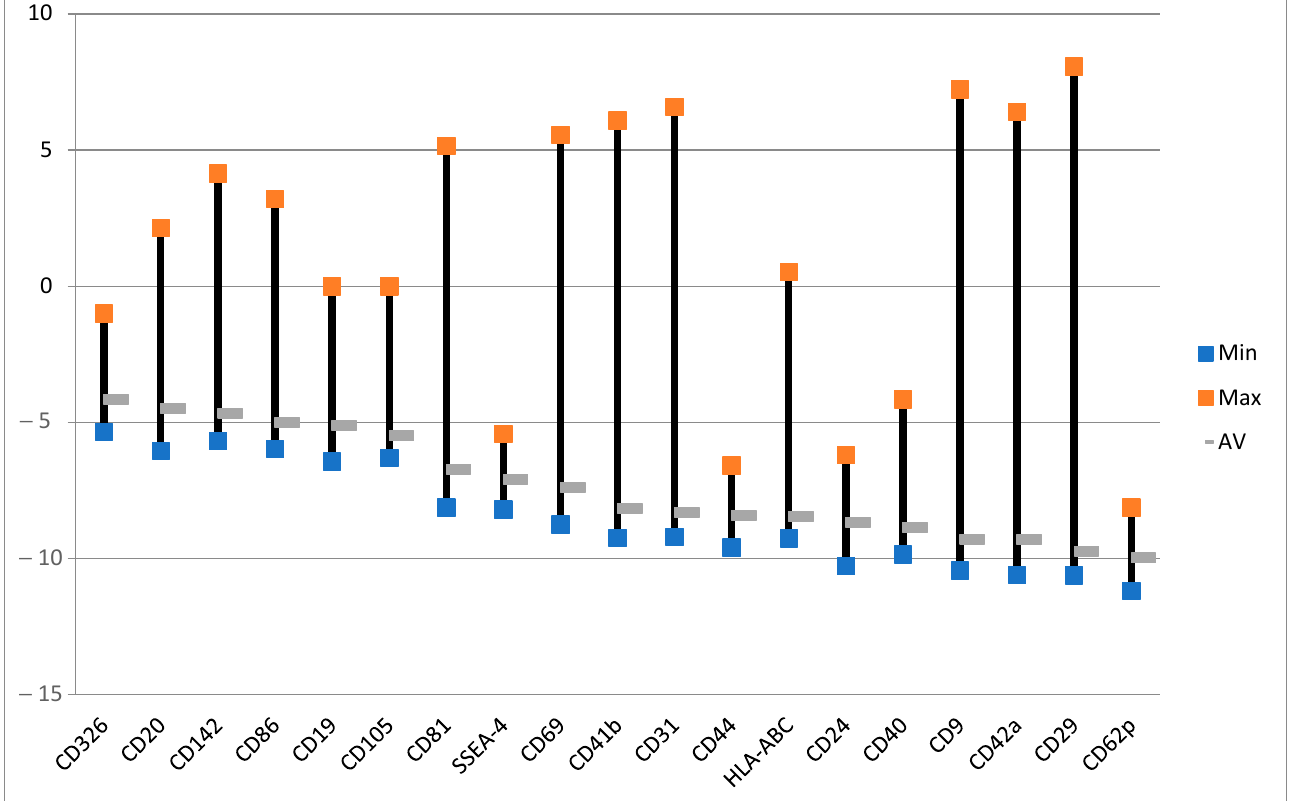
Figure 10. Effects of ALA and red light on the selected exosomes. Exosomes with the lowest variabilities. The data are presented as minimal, maximal, and average log values. Log = sgn (PDT i − ALA i )*log 2 (|PDT i − ALA i |), where PDT i is the exosome fluorescence intensity in the PDT group with